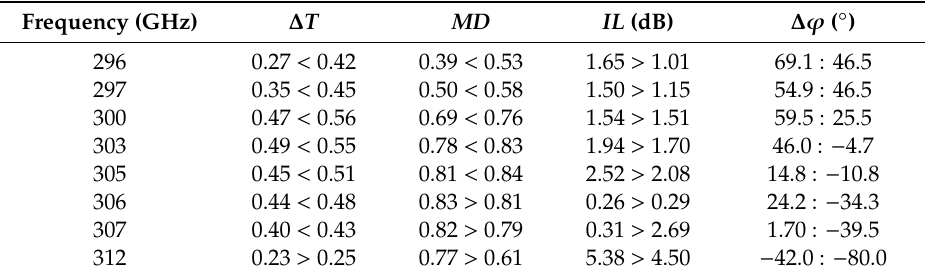
Figure 5. ( a ) Transmission spectra of the LC E7 sample. ( b ) Phase information of the LC E7 sample. ( c ) Transmission spectra of the LC E7-2 sample. ( d ) Phase information about the LC E7-2 sample. Table 2. Comparison of two LC samples (E7 and E7-2) at certain frequency points. Frequency (GHz) Δ T